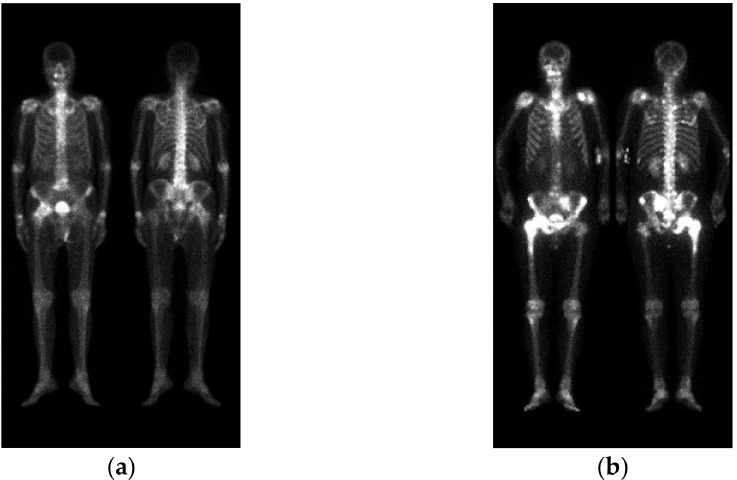
Figure 1. WBBS images: ( a ) the patient has no bone metastasis and ( b ) the patient has some bone metastasis hotspots on the rib and spinal cord. The pelvis has a large-area